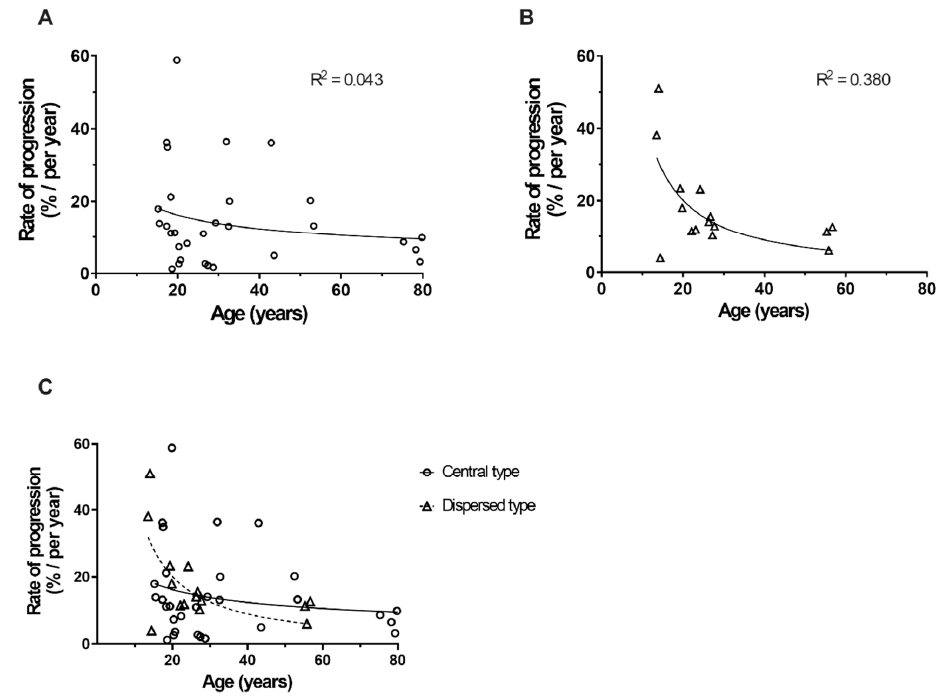
Figure 4. Annual lesion progression rate in patients with Stargardt disease 1 across different age groups. ( A ) Central type Stargardt disease 1. ( B ) Dispersed type Stargardt disease 1. ( C ) Comparison of the central type and dispersed type lesion areas in different age groups. Note: progression rate is calculated using the increment (or decrement) of the previous visit lesion areas in fundus autofluorescence divided by the interval time from the last visit.